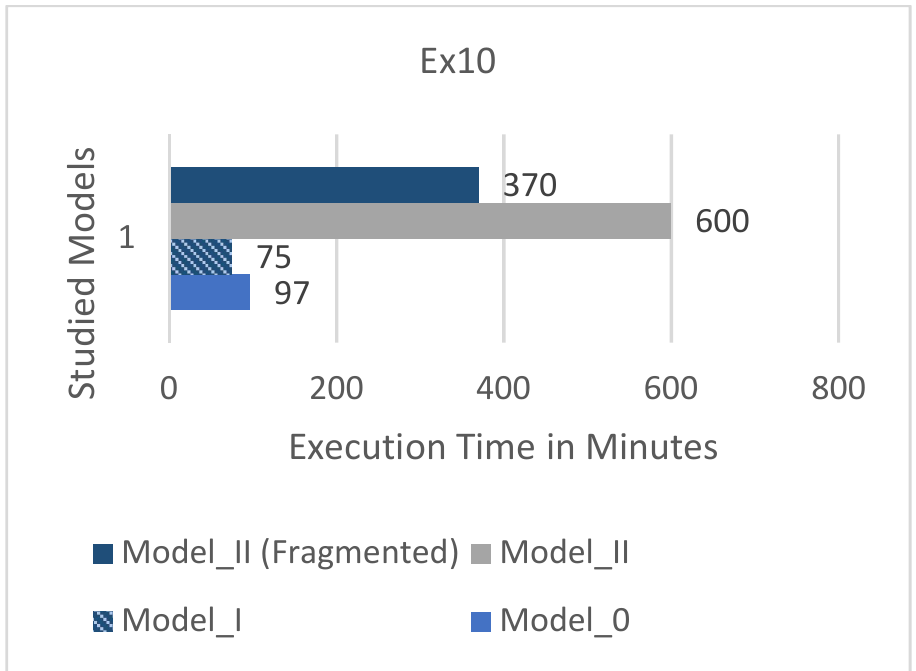
Figure 17. Obtained prediction accuracies of fragmenting Dataset_VI with fragmentation sizes of 0.1, 0.2, and 0.3 and applying Model_II with each resulting dataset (EX09).